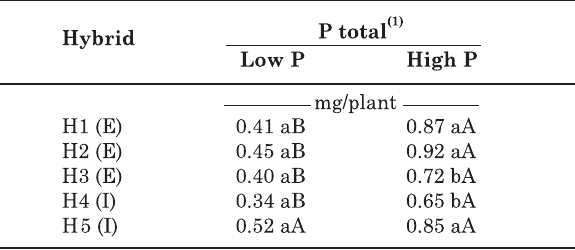
Table 2. Total phosphorus accumulated in plant tissues (shoot and root) of maize hybrids grown in P-rich and P–poor